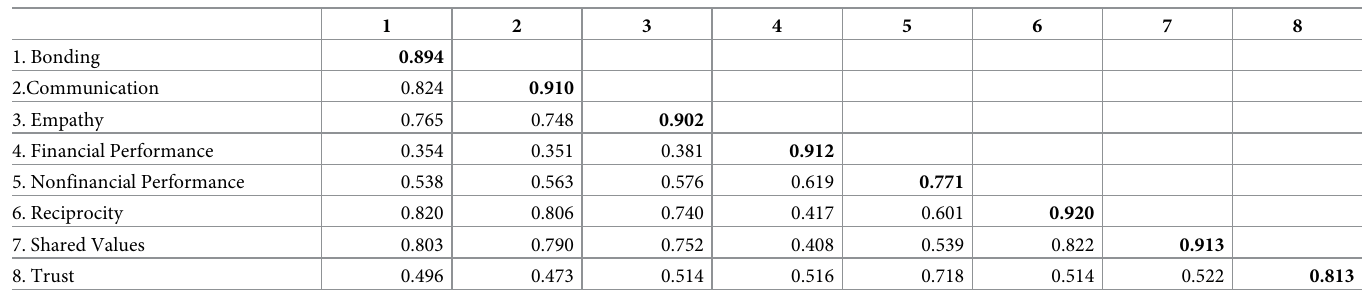
Table 3. Discriminant validity indicating AVE and correlations.